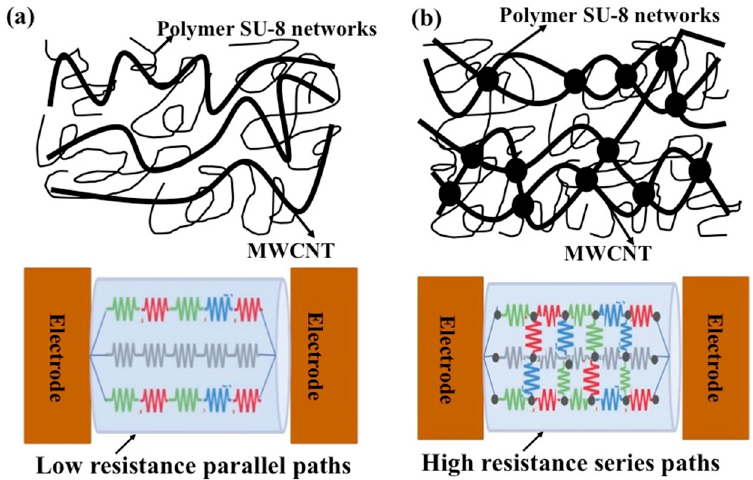
Figure 7. A resistor network model for MWNCT-embedded SU-8 nanofiber co-percolating system: ( a ) Low resistance parallel paths; ( b ) Interconnection of parallel paths leading to high resistance percentage.